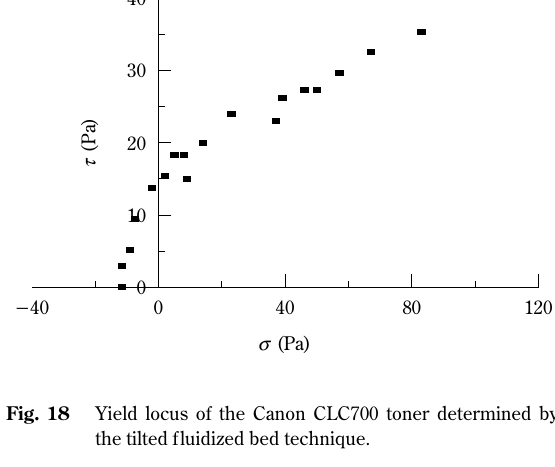
Yield locus of the Canon CLC700 toner determined by the tilted fluidized bed technique.